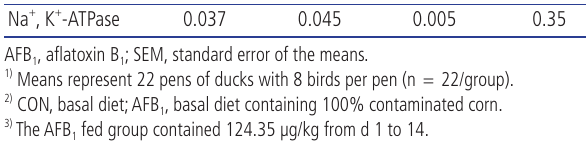
Table 8. Effects of feeding corn naturally contaminated with AFB expression of jejunum Na + , K + -ATPase gene in ducklings 1)